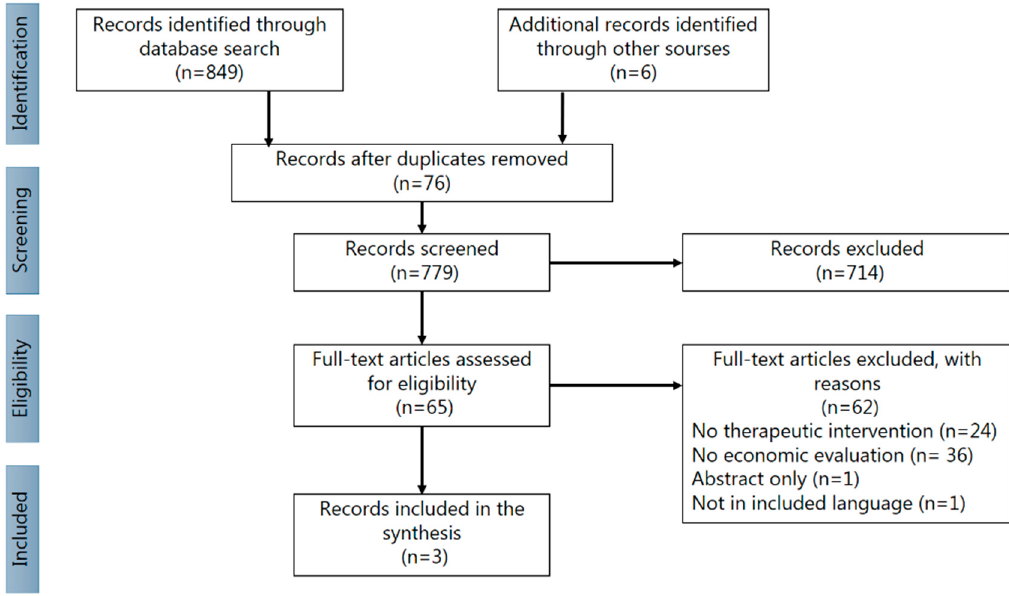
Figure 1. Flowchart of search procedures and study selection. Source: [41].